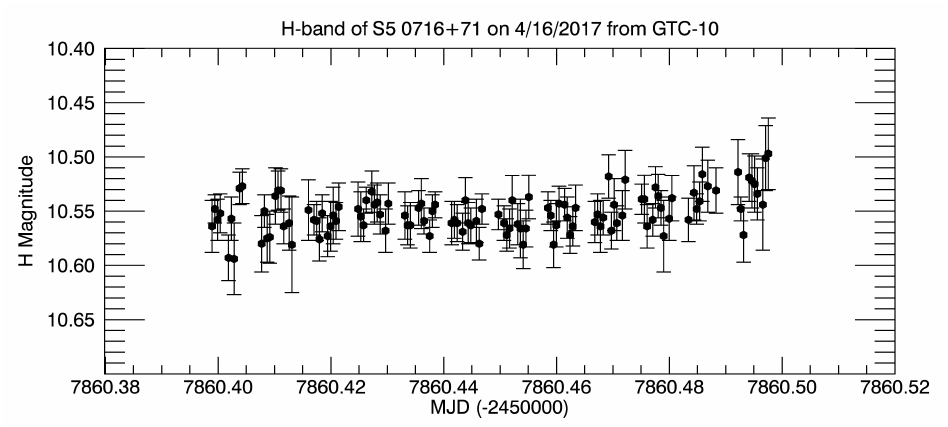
Figure 4. H-band magnitudes from CIRCE during the 16 April 2017 joint observation. The data showed a hint of an upturn at the end similar to that seen in the optical.